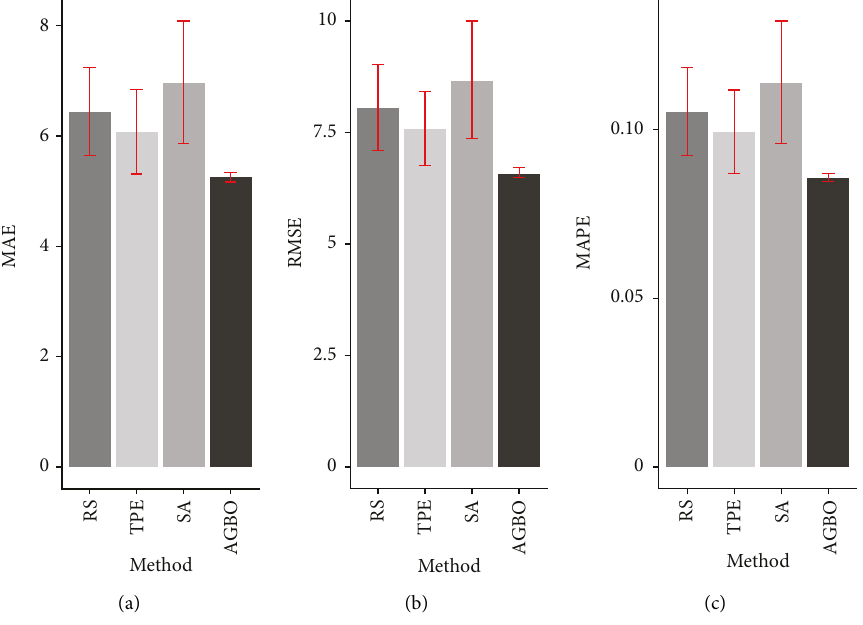
Figure 11: The bar chart with error bars from results of MAE (a), RMSE (b), and MAPE (c). Table 6: The results of parameter identification repeated 25